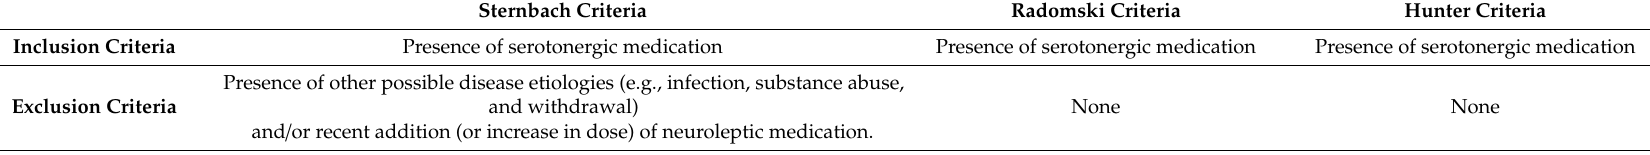
Table 1. Comparison between the Sternbach, Radomski, and Hunter Criteria for diagnosing serotonin toxicity.